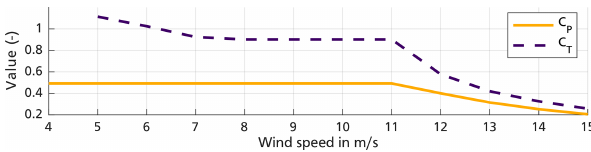
Figure 4. Greedy control settings of the un-yawed 10MW DTU reference turbine based on the effective rotor wind